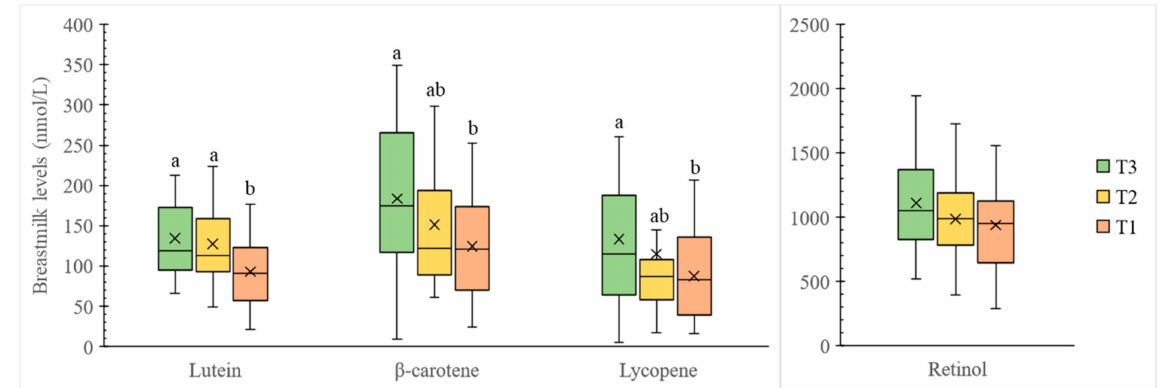
Figure 2. Box plots of major carotenoid and retinol contents (nmol/L) in breastmilk categorized by total carotenoid intake from food and supplements. Boxes represent the 25th, 50th, and 75th percentiles. Crosses represent mean. Whiskers represent either minimum/maximum or 25th/75th minus/plus 1.5 × interquartile range, whichever is closer to the median. Different superscript letters indicate a significant difference in carotenoid or retinol content in human milk from different groups ( p < 0.05) based on one-way ANOVA test with post hoc Bonferroni test. Participants in T3 ( n = 29) had the highest carotenoid intake of 10.2–32.0 mg/day, T2 ( n = 29) had the median carotenoid intake of 6.5–10.1 mg/day, and T1 ( n = 29) had the lowest carotenoid intake of 0.9–6.2 mg/day.